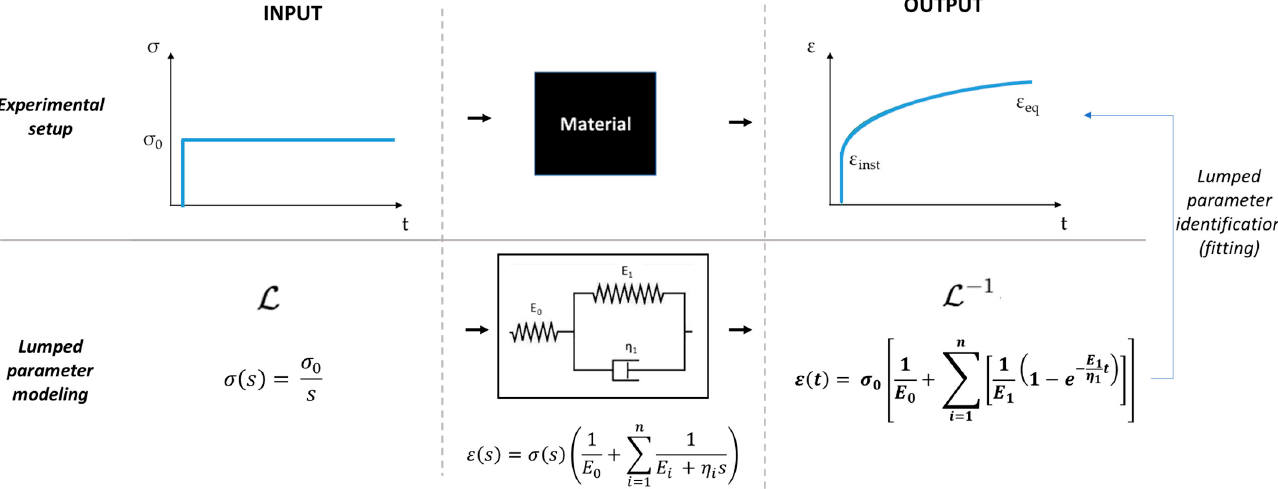
Figure 3. Summary of the experimental setup and acronyms: ( A ) samples tested in the bioreactor, i.e., cell-laden gels (CG), cell-laden gels with exogenous mTG (CG-ex), gels (G) and gels with exogenous mTG (G-ex); ( B ) monolayers in multiwell plates cultured in the absence (M) and in the presence of exogenous mTG (M-ex).